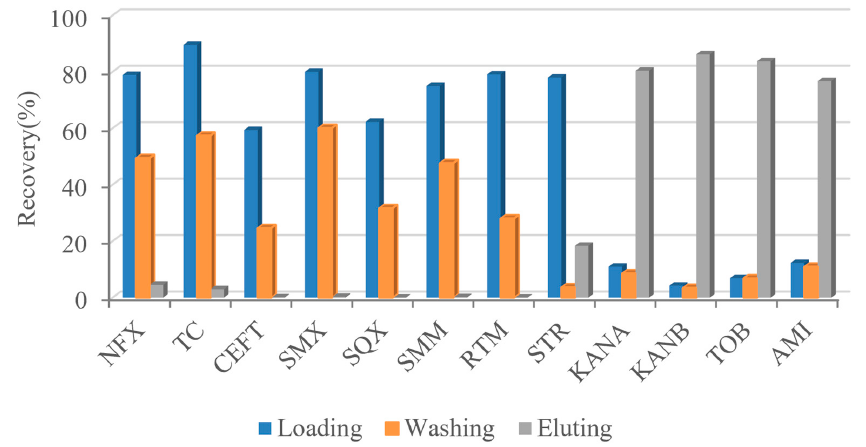
Figure 7. Specificity of AAC to AGs.